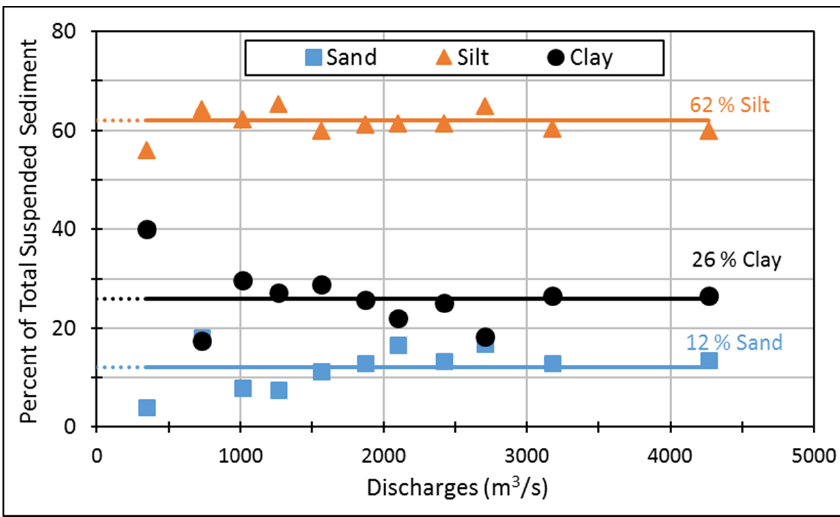
Figure 5. Percentage variation of sand, silt and clay for Jhelum River.